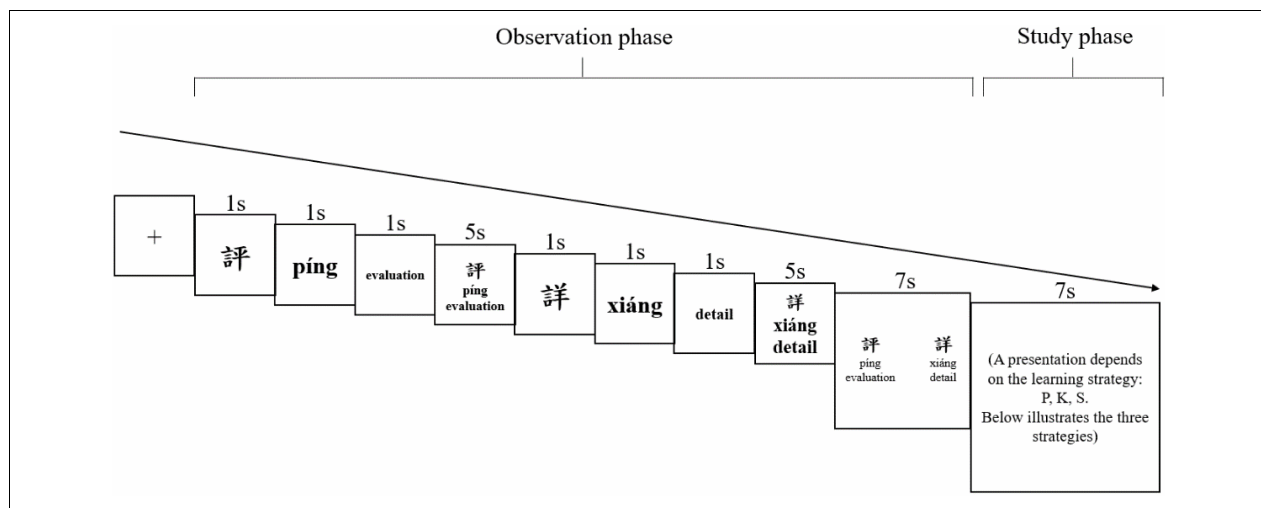
FIGURE 1 | An example of the observation and the study phases for learning character pair